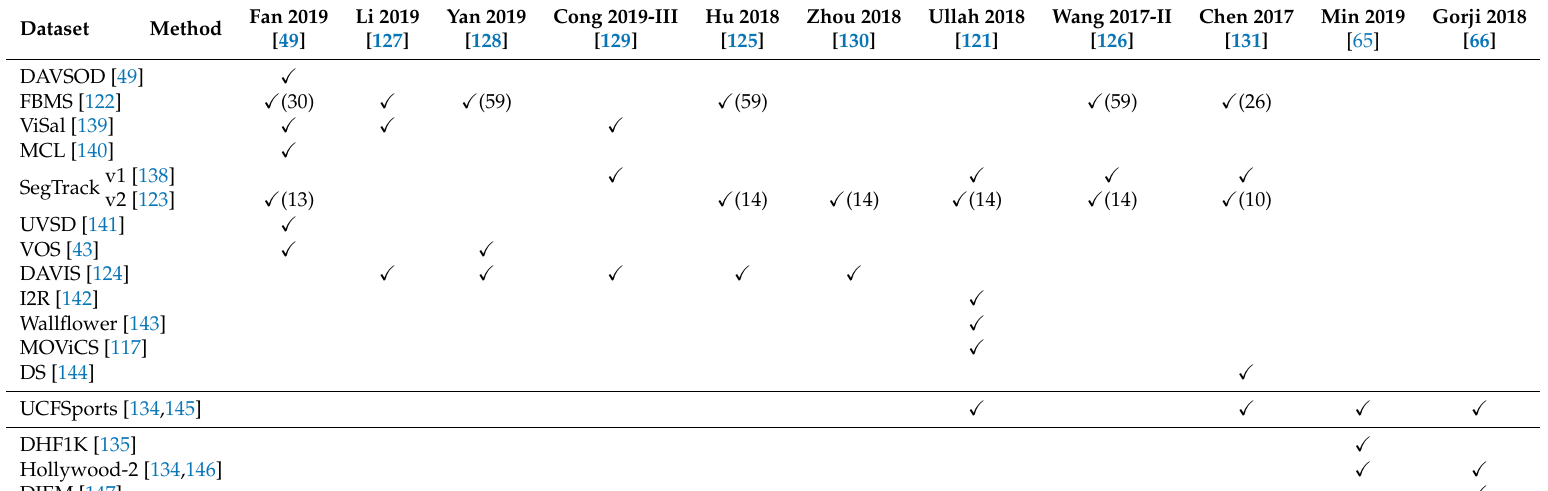
Table 10. Dataset/method matrix for video saliency estimation. The number in parentheses identifies the version of the dataset through the corresponding cardinality of video